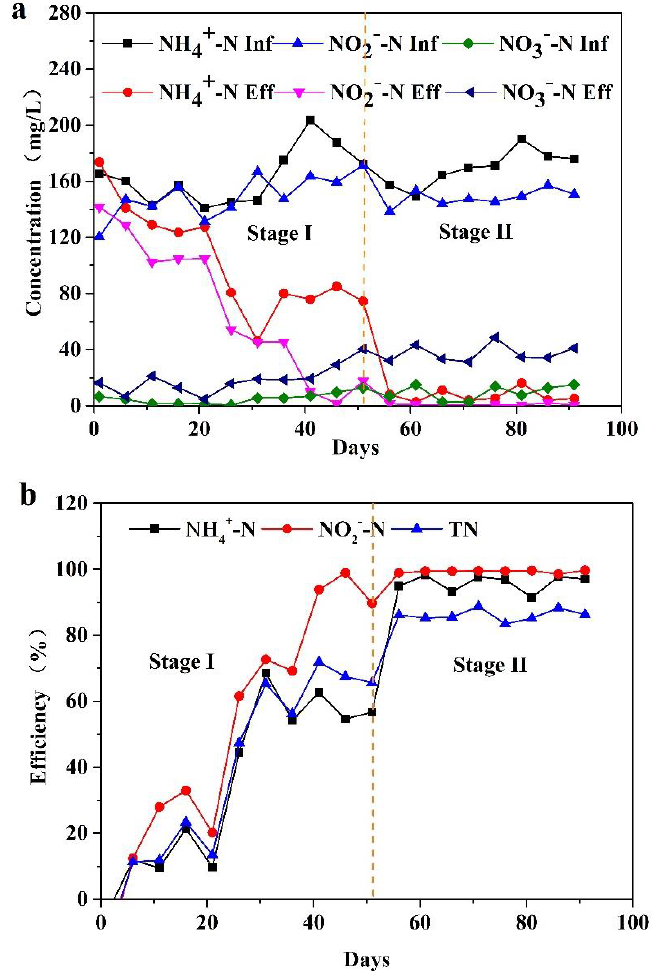
Figure 2. Concentrations (a) and removal efficiencies (b) of N-compounds in the influent and efflu- ent of the reactor. of the